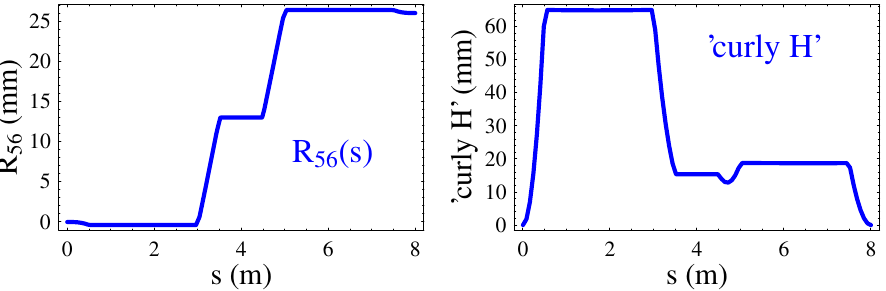
FIG. 7. (Color) Comparison between model of smearing from horizontal emittance discussed in this section (dots) and linear theory (lines). The gain curves are for the FERMI first bunch compressor and are shown for two values of normalized horizontal emittance. The beam peak current (before compression) is I (cid:1) 191 : 1 A (twice the design value). The beam energy is E (cid:1) 233 MeV , the energy (cid:1) 10 keV . spread (cid:10) p